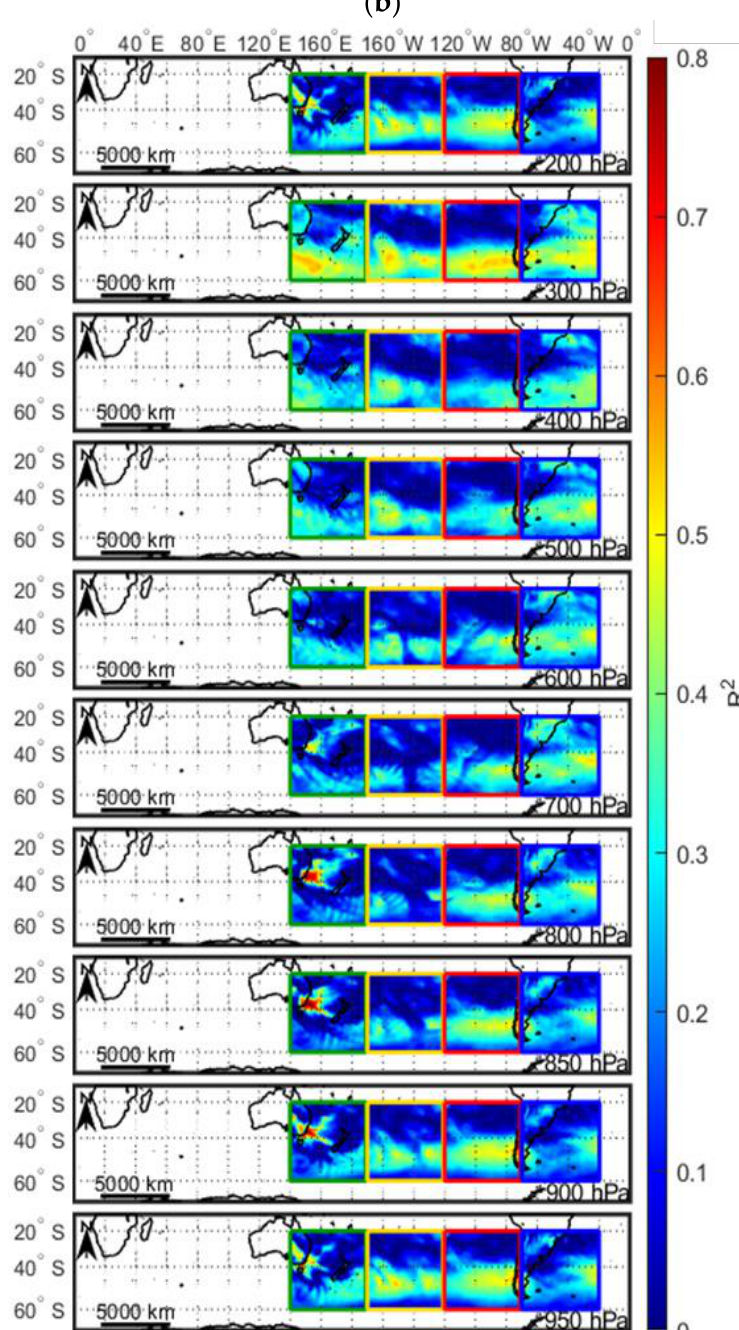
Figure 6. ( a ) Relative differences of CO and O 3 calculated for the study period (25 December 2019 to 12 February 2020) over the study area (20° to 60° S and 140° E to 20° W), with respect to the same days through the years 2004–2019 (base period). ( b ) R 2 between CO and O 3 relative differences with respect to the base dataset, at various pressure levels (950–200